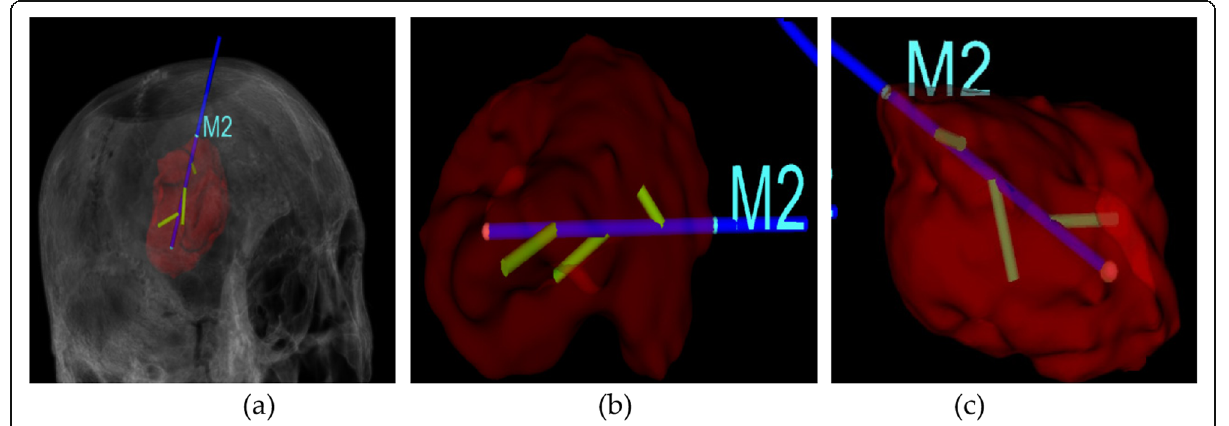
Fig. 9 Route planning. M 2 denotes the accurate position of the puncture